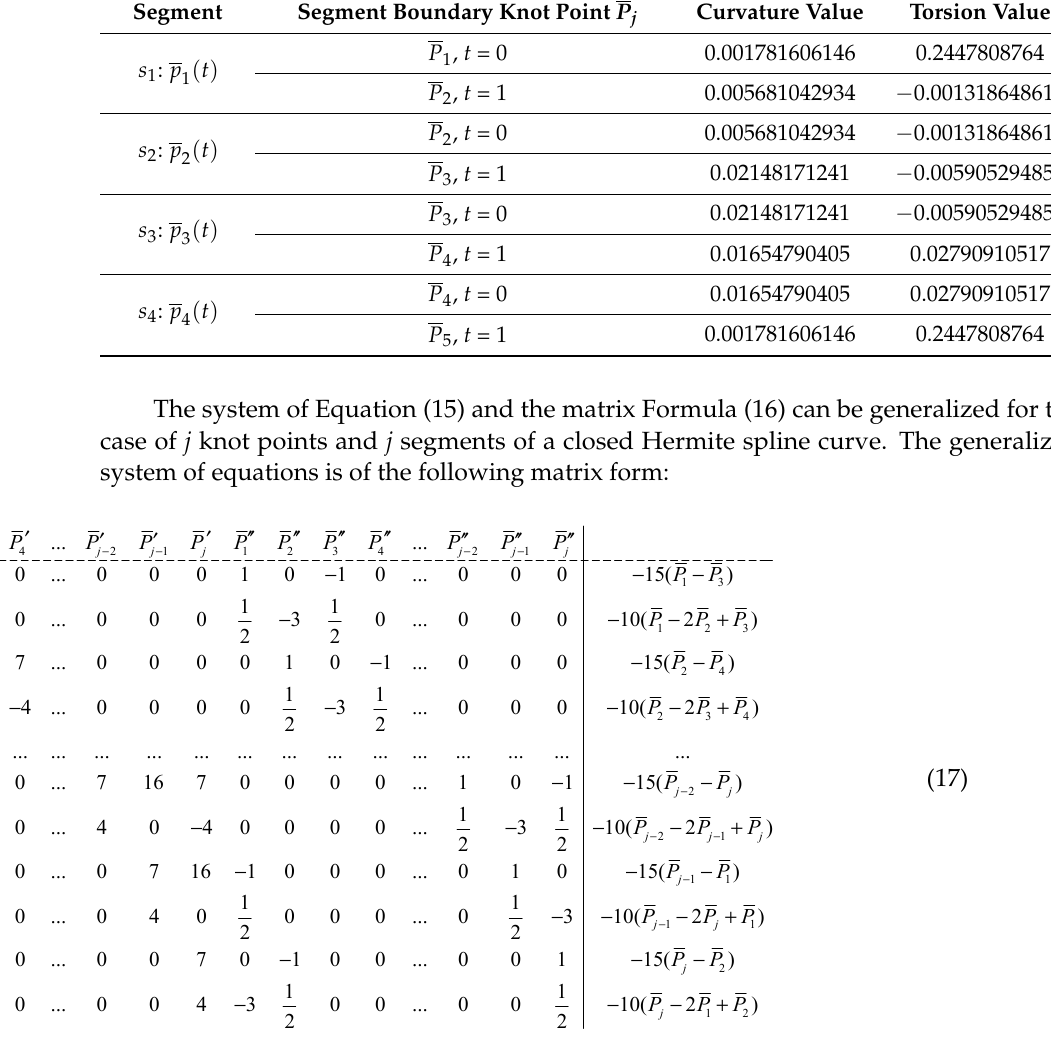
Table 4. Curvature and torsion values at boundary points of the segments.